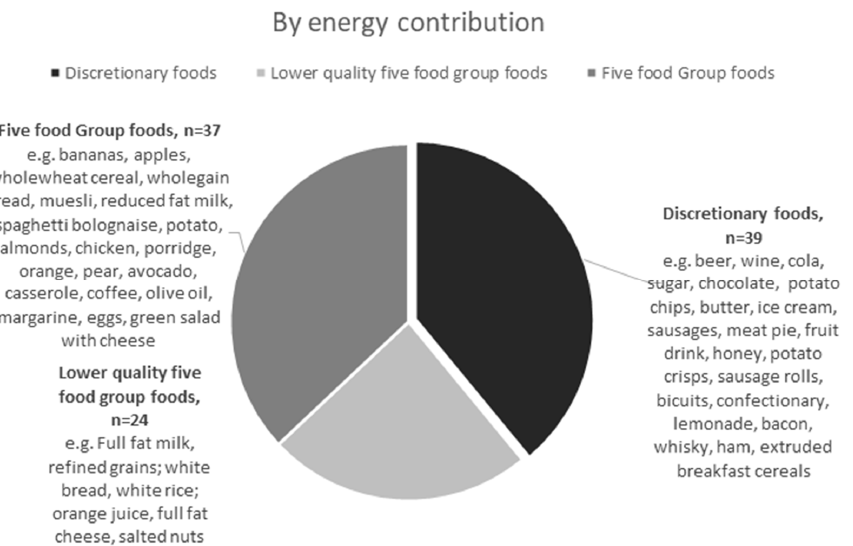
Figure 1. Number of the 100 most popular foods by energy contribution that were classified as five food group, lower quality five food group and discretionary foods, with a selection of the foods in each category listed.